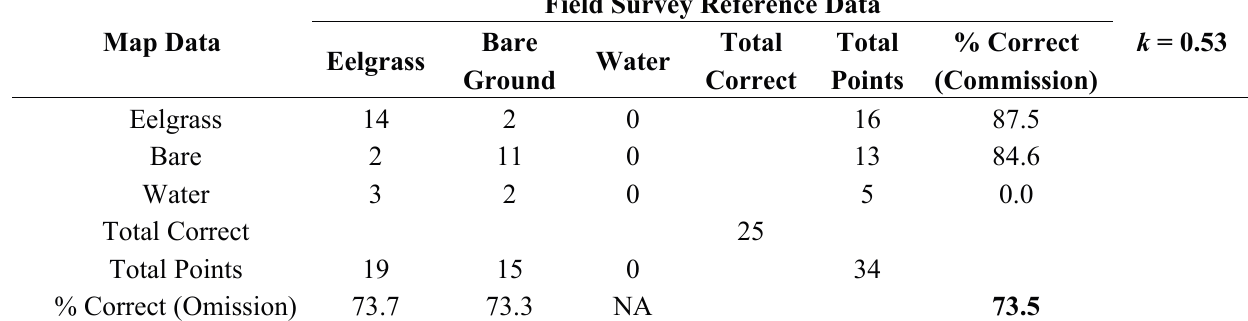
Table A8. Initial classification of habitats in Middle Lagoon.